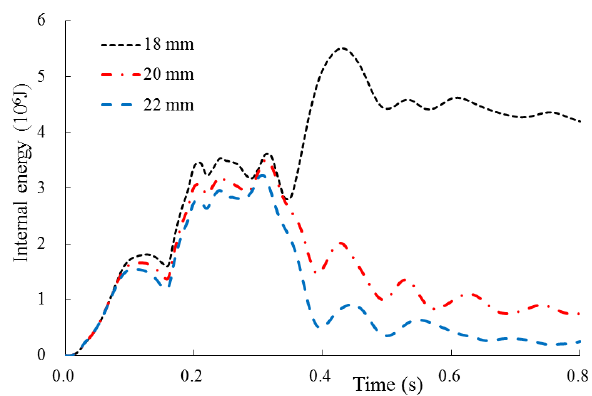
Figure 19. The internal energy time-history of steel plates with different